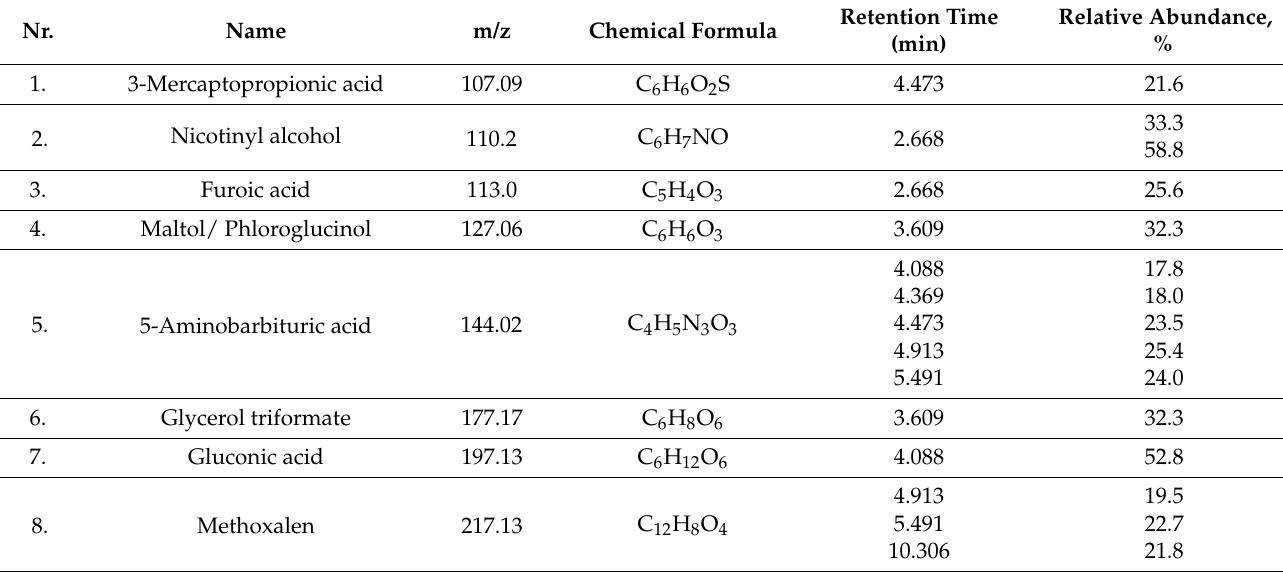
Table 6. Possible bioactive compounds identified in the hydrolyzed sample in MS spectra with positive ionization.